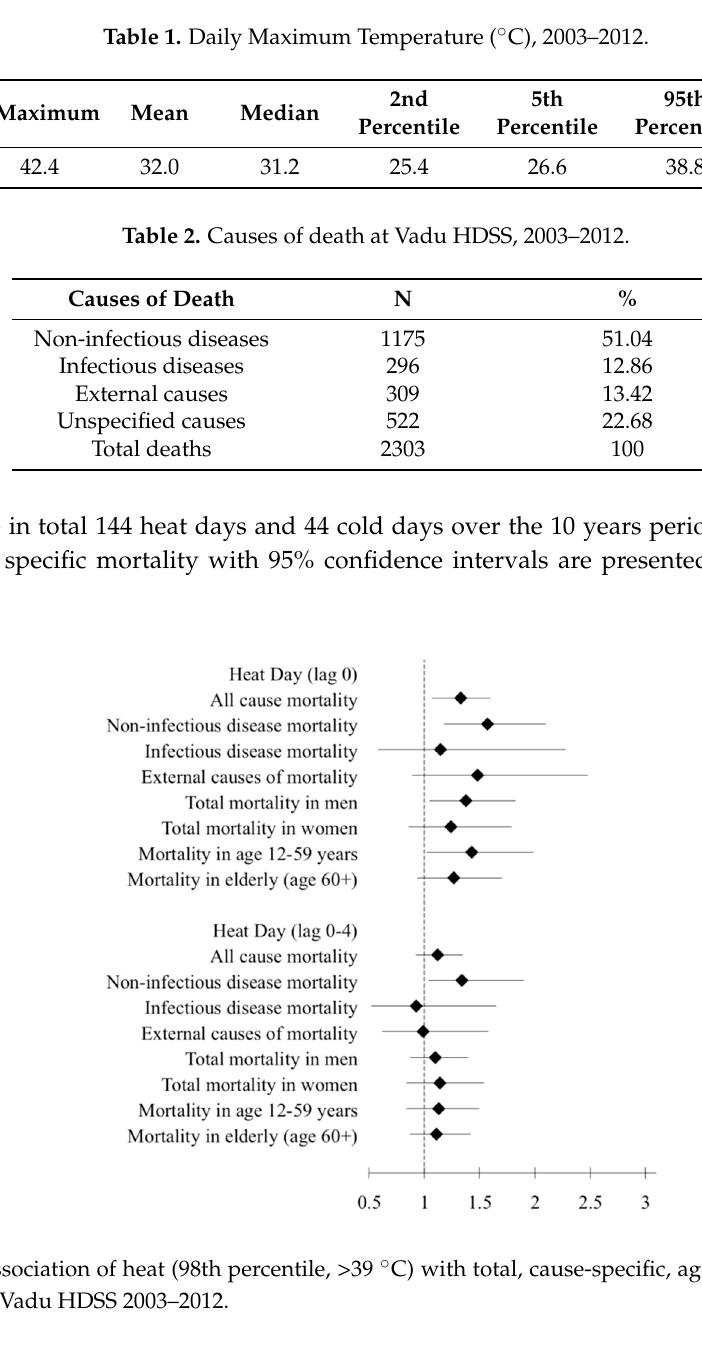
Table 1. Daily Maximum Temperature (°C), 2003–2012.